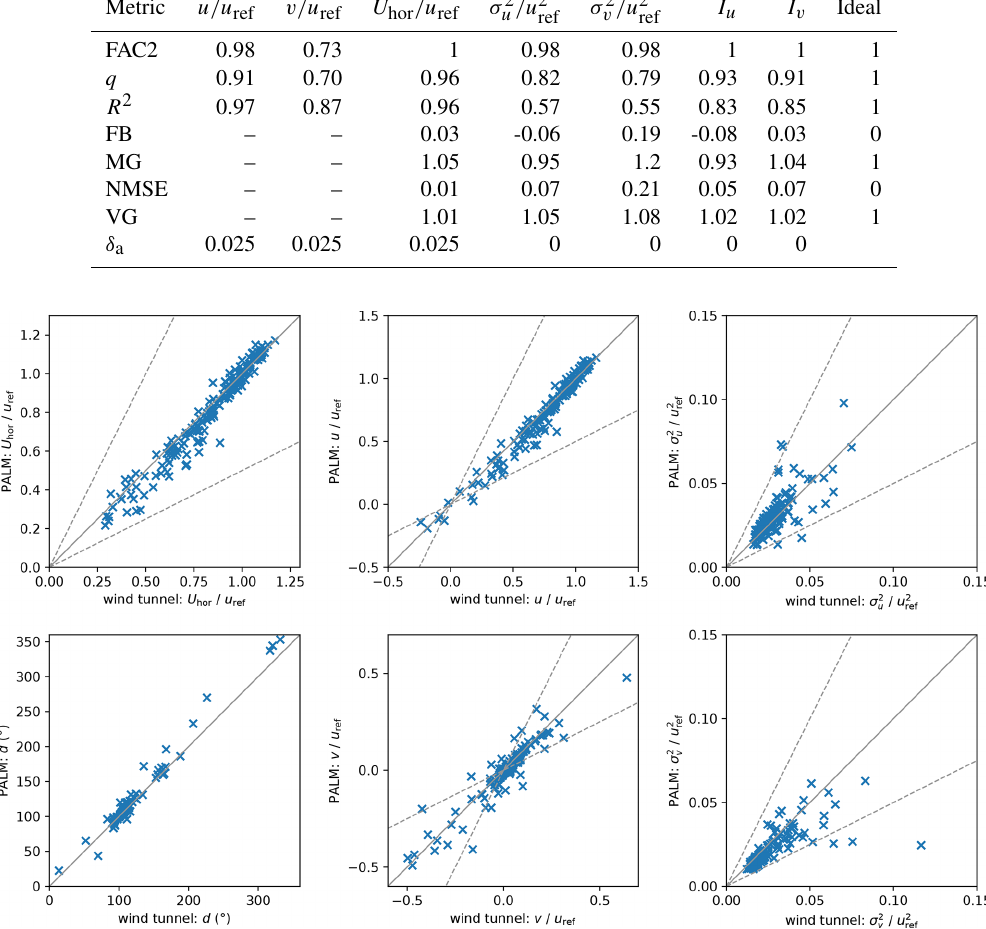
Figure 10. Scatter plots of wind tunnel and PALM measurements of horizontal wind speed U hor , wind direction d , wind-velocity components u and v , and their variance σ 2 u and σ 2 v for all 25 measurement stations and all heights (173 data pairs in total). Solid lines indicate perfect agreement and dashed lines indicate the area between a deviation factor of 0.5 and